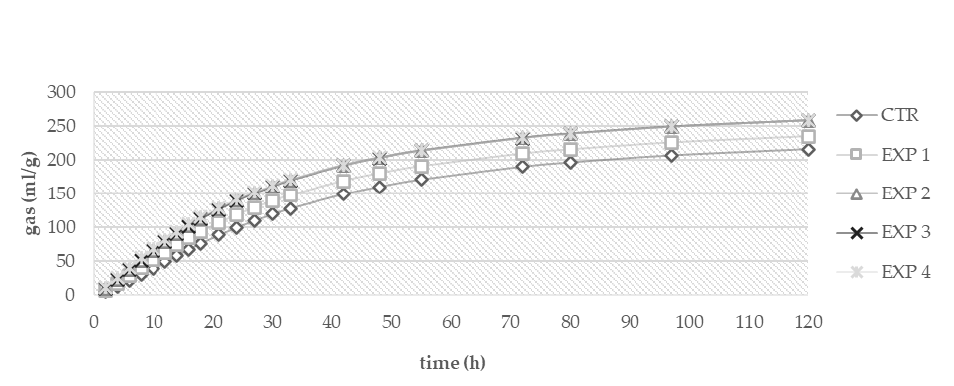
Figure 1. In vitro gas production over time in control and experimental diets with buffalo